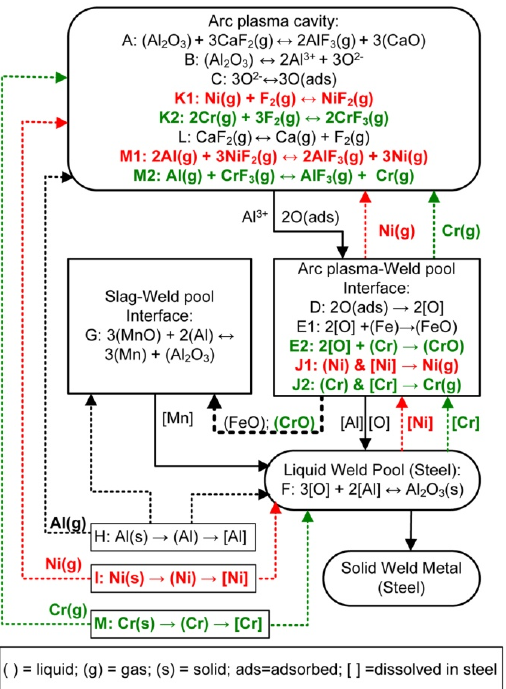
Figure 7. SAW reaction flow diagram with Al, Ni, and Cr powder additions [31].